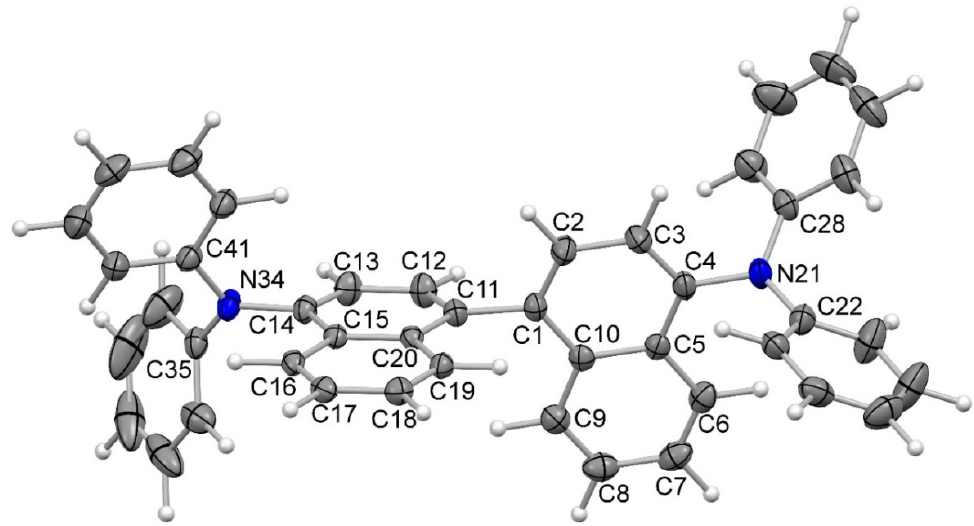
Figure 3. Molecular structure of N , N , N ’, N ’-tetraphenylnaphthidine ( 4 ) in the crystal (ORTEP plot showing thermal ellipsoids at the 50% probability level). Selected bond lengths (Å): C1–C2 1.370(3),